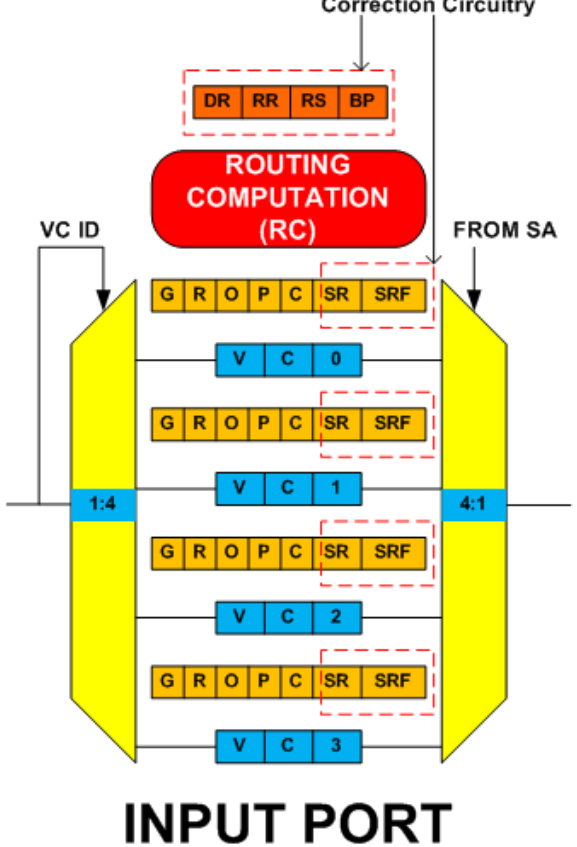
Figure 3. Fault-Tolerant RC Unit